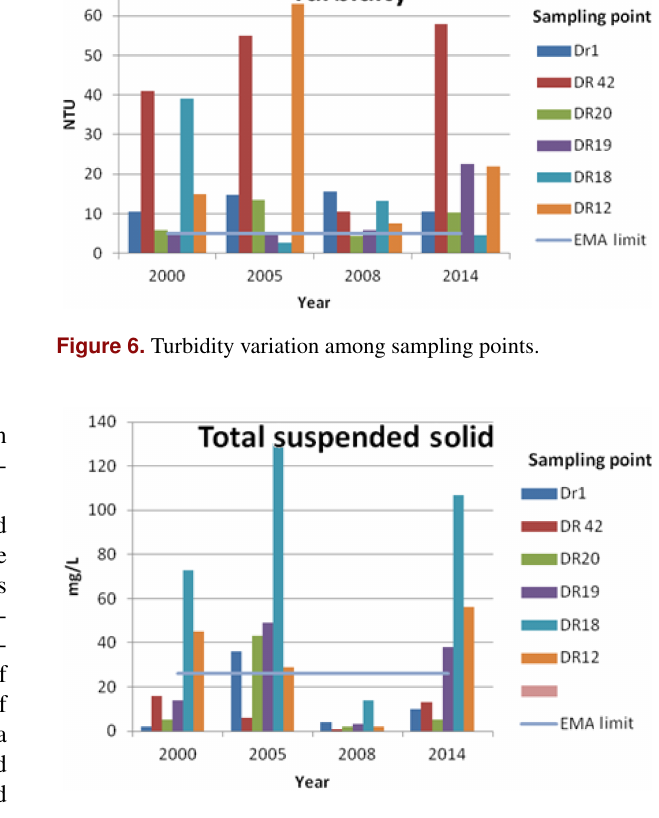
Figure 7. Total Suspended Solids variation among sampling